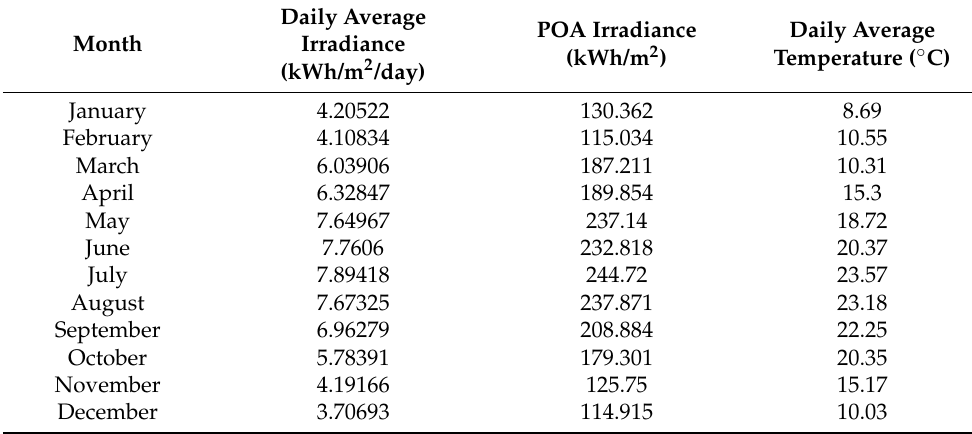
Table 6. Average solar energy and ambient temperature in Nablus